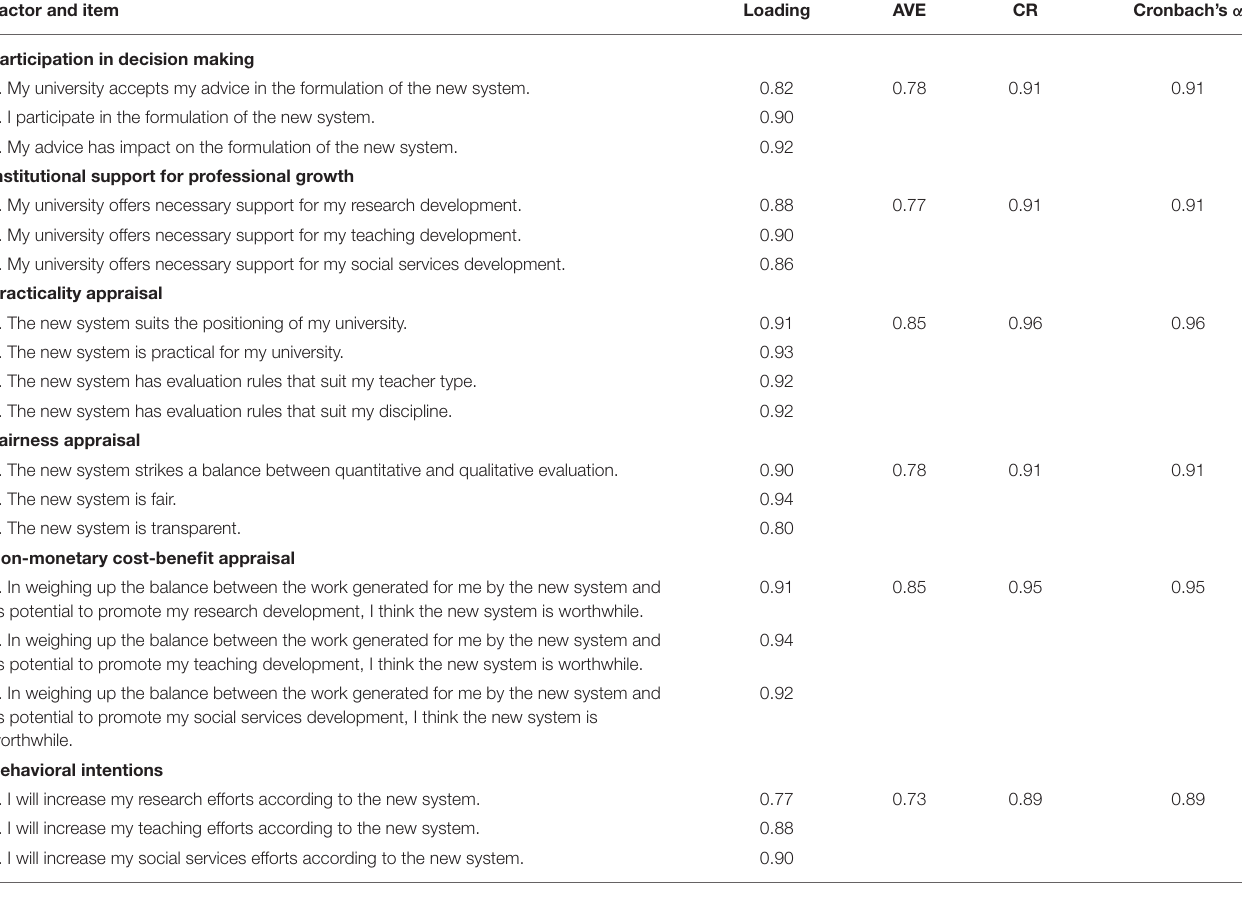
TABLE 1 | Loading, AVE, CR, and Cronbach’s α of the subscales ( N = 372). Factor and item